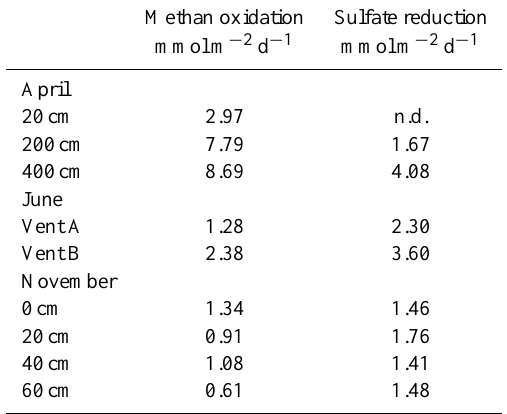
Table 1. Areal rates of methane oxidation and sulfate reduction. Replicates were averaged ( n =2–4) and integrated over 10cm sedi- ment depth. n.d.=not